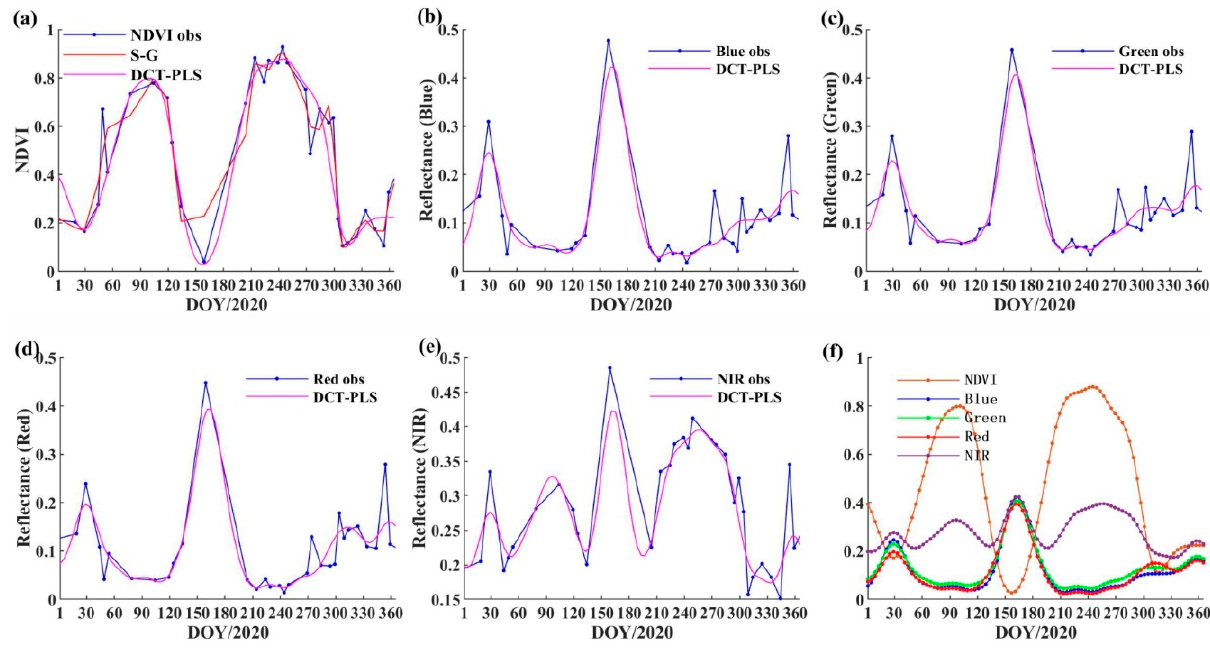
Figure 5. The comparison of NDVI and band reflectance time series from Sentinel-2, the DCT-PLS and SG filter methods for the rotation of rice sample in 2020. ( a ) The NDVI time series; ( b – e ) The surface reflectance time series in blue, green, red and NIR band, respectively; ( f ) The reconstructed NDVI and all the band reflectance time series from the DCT-PLS method.